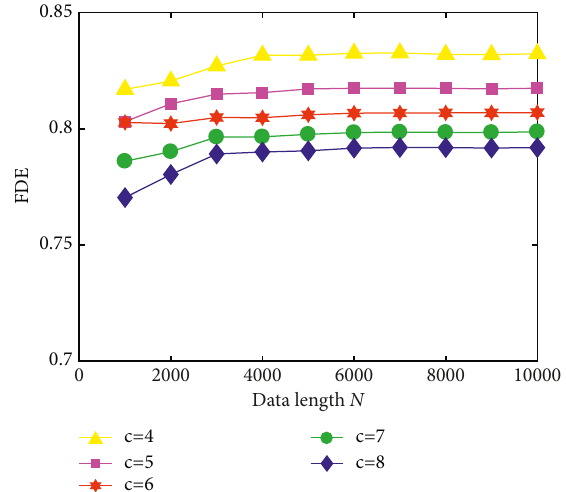
Figure 2: The FDE values of the signal under various